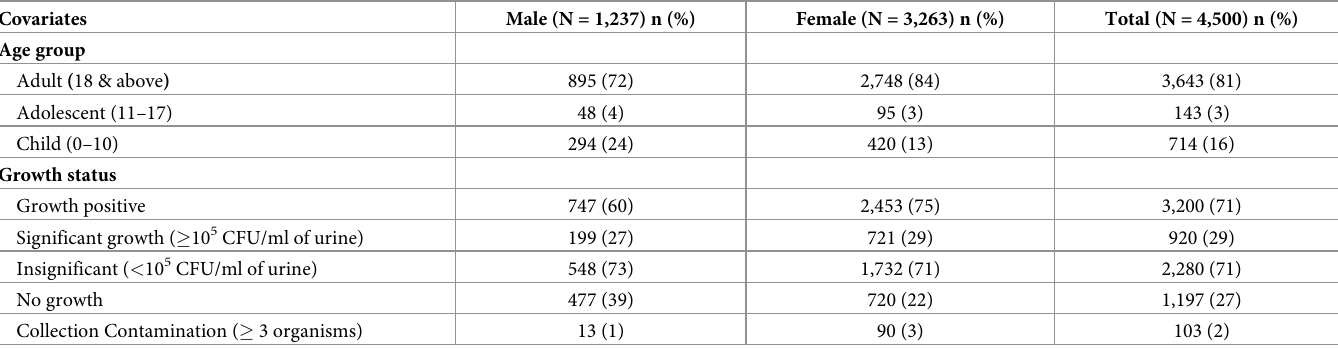
Table 1. Characteristics of patients according to their age, sex and urine culture status.